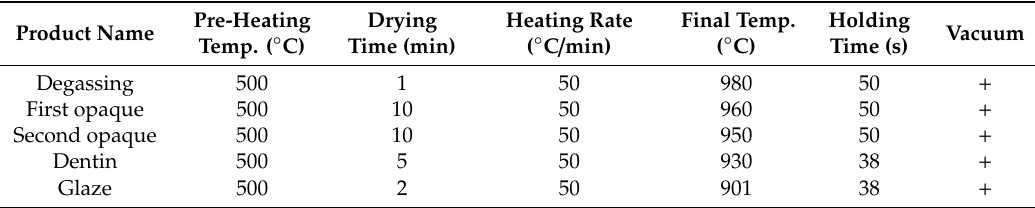
Table 2. Firing schedules used in the ceramic veneering procedure.